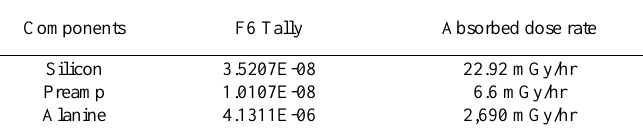
T ABLE I THE EXPERIMENTAL ABSORBED DOSE RATES ON EACH COMPONENT Components F6 Tally